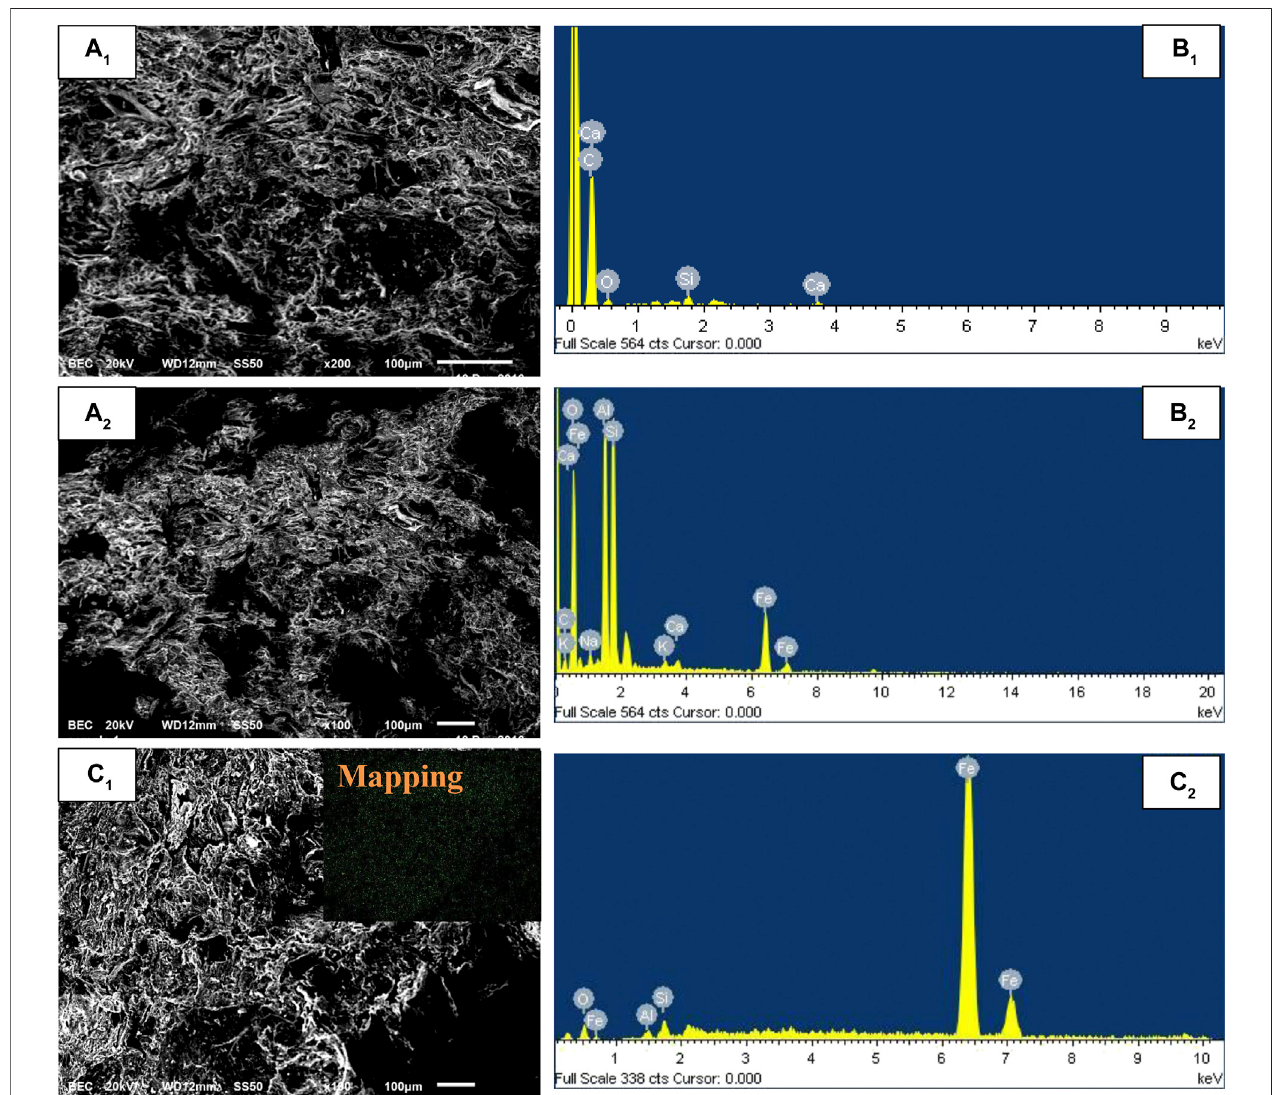
FIGURE 2 | SEM images of (A 1 ) PAC, (B 1 ) PAC-mZVI, and (C 1 ) PAC-nZVI and EDX images of (A 2 ) PAC, (B 2 ) PAC-mZVI, and (C 2 ) PAC-nZVI.